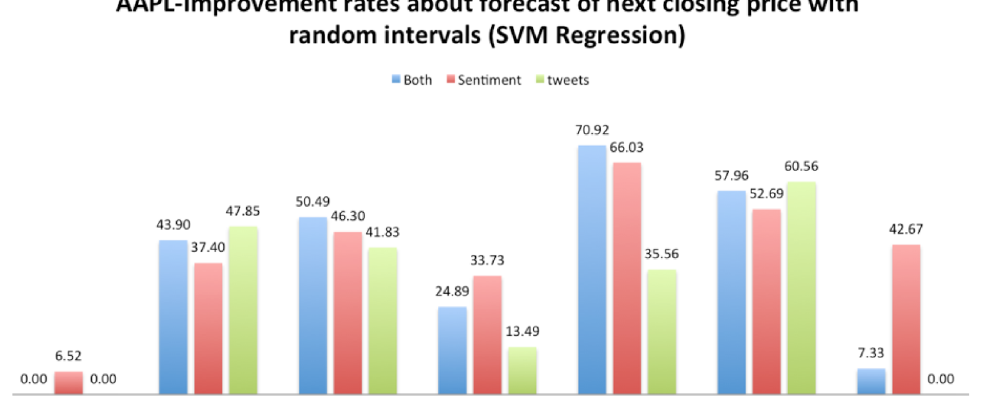
Figure 12. Improvement rates (expressed in %) at random intervals about AAPL by using SVM